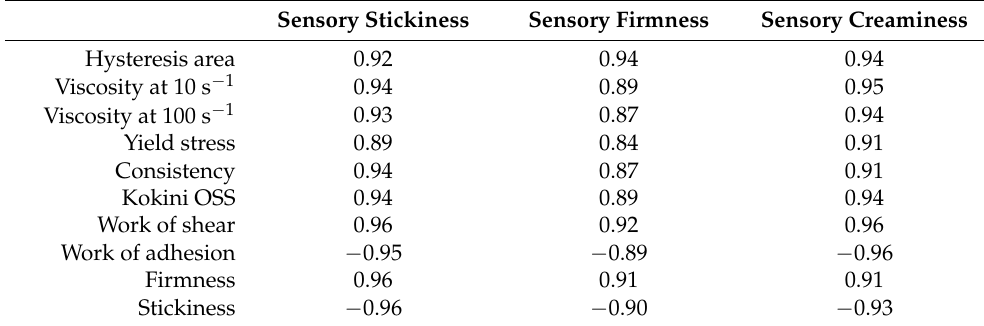
Table 5. The Pearson correlation coefficient between the sensory attributes of stickiness, firmness, and creaminess, and the results of rheology, texture analysis, and spreadability